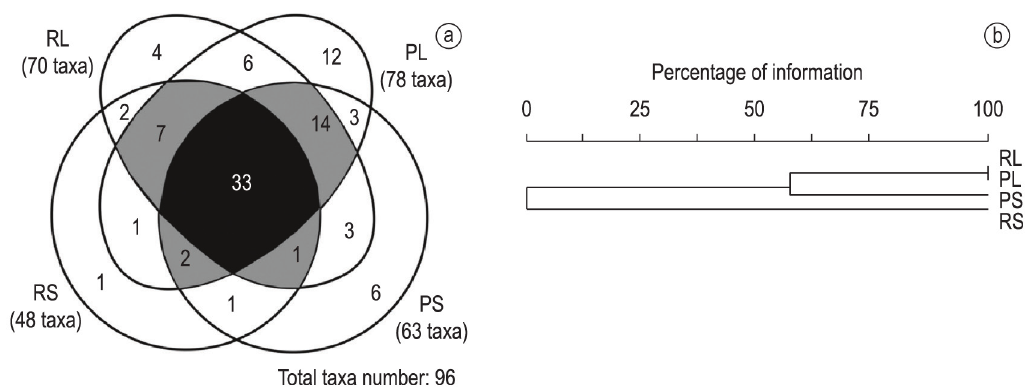
Figure 4. Schematic diagram of the distribution (a) and Grouping analysis by Jaccard Coefficient (b) of the Chironomidae taxa per microhabitats sampled. RL: riffle litter, PL: pool litter, RS: riffle sediment, PS: pool